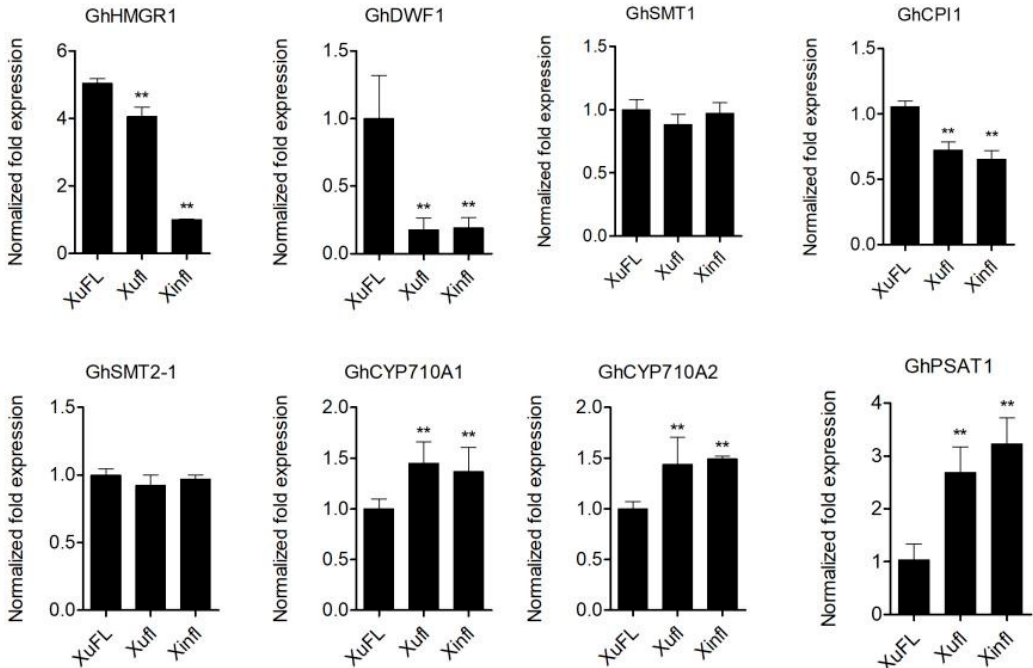
Figure 7. The differential gene expression for sterol and steryl ester synthesis between wild-type and two mutants. HMGR (3-hydroxy-3-methylglutaryl-CoA reductase), SMT1 and SMT2 (C24-sterol methyltransferases 1 and 2), and CYP710A1 and CYP710A2 (C22-sterol desaturase), PSAT (phospholipid:sterol acyltransferase), CPI1-1 (cyclopropylsterol isomerase1-1), GhDWF1 (SSR2, sterol side chain reductase 2). XuFL, wild-type Xuzhou 142; Xufl , Xuzhou 142 lintless-fuzzless mutant; Xinfl , Xinxiangxiaoji lintless-fuzzless mutant. Three independent RNA isolations were used for cDNA synthesis, and each cDNA sample was subjected to quantitative real-time PCR analysis in triplicate. Error bars represent the SD. Statistical data analysis was performed by the one-tailed student’s t -test. ** indicate significant differences at p < 0.01.